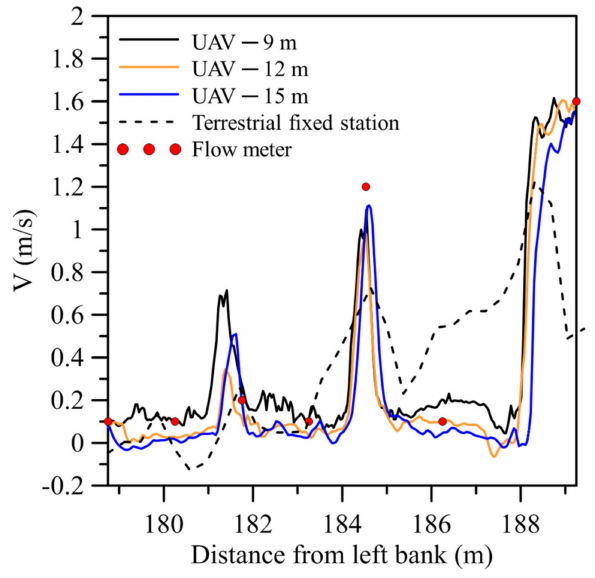
Figure 6. Comparison of measured surface velocities using different UAV flight heights, terrestrial fixed stations, and flow meters.